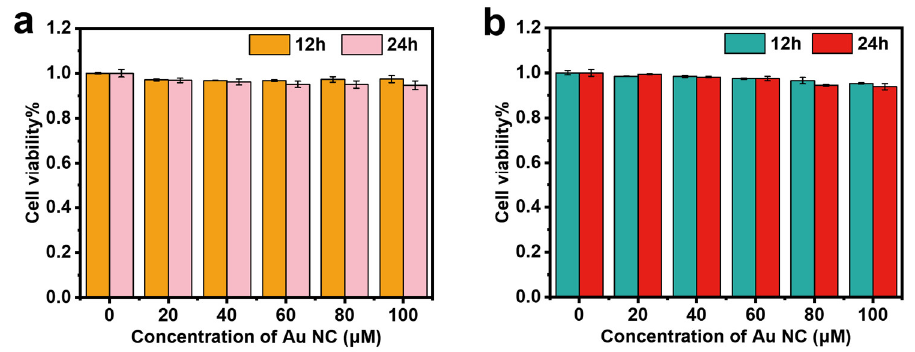
Figure 6. The viability of ( a ) NIH 3T3 and ( b ) HeLa cells after treatment with different concentrations